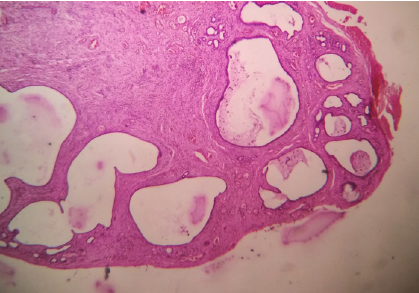
Figure 2: Multiple cystic spaces supported by a connective tissue stroma.